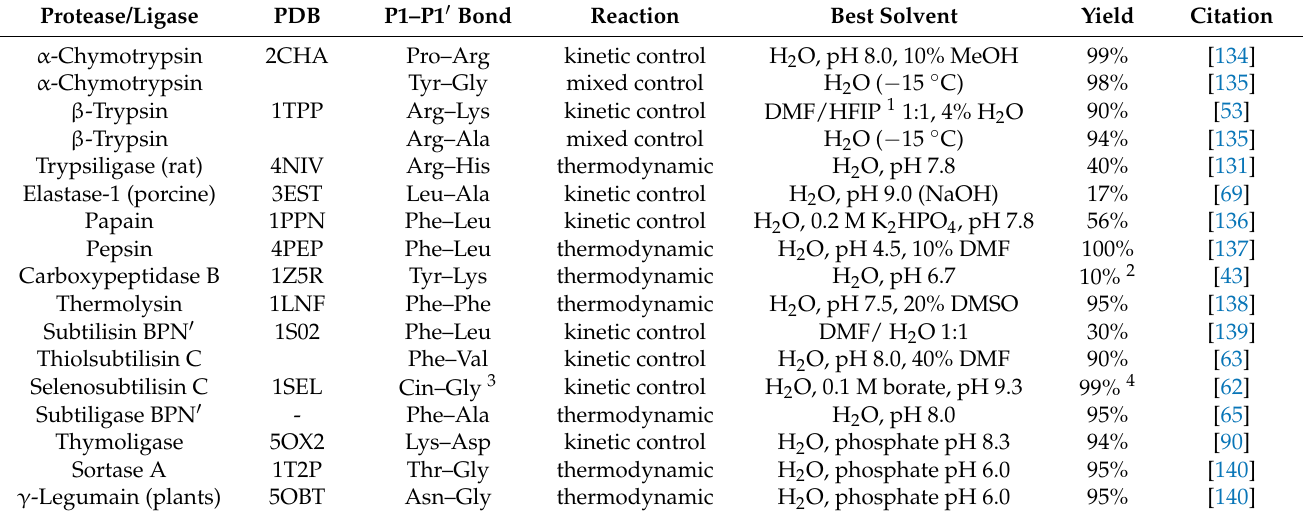
Table 1. Structural and functional parameters of ligating proteases. PDB codes, ligated bond (often involving modified amino acids or peptides), reaction conditions, and yields are shown. The listed enzymes were regularly used to catalyze peptide bond formation and for linking proteins with modifying molecules of various types. 1 HFIP, hexafluoroisopropylalcohol; 2 the yield is estimated from a chromatogram.; 3 Selenolsubtilisin C derived from subtilisin Carlsberg transfers a cinnamoyl acyl intermediate to H 2 N–Gly; 4 yield estimated from a 4-times higher rate constant compared to